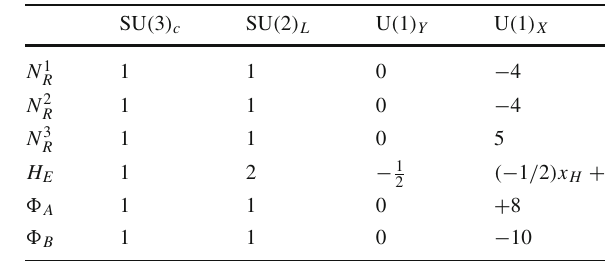
Table 2 New particle content of the alternative U ( 1 ) X